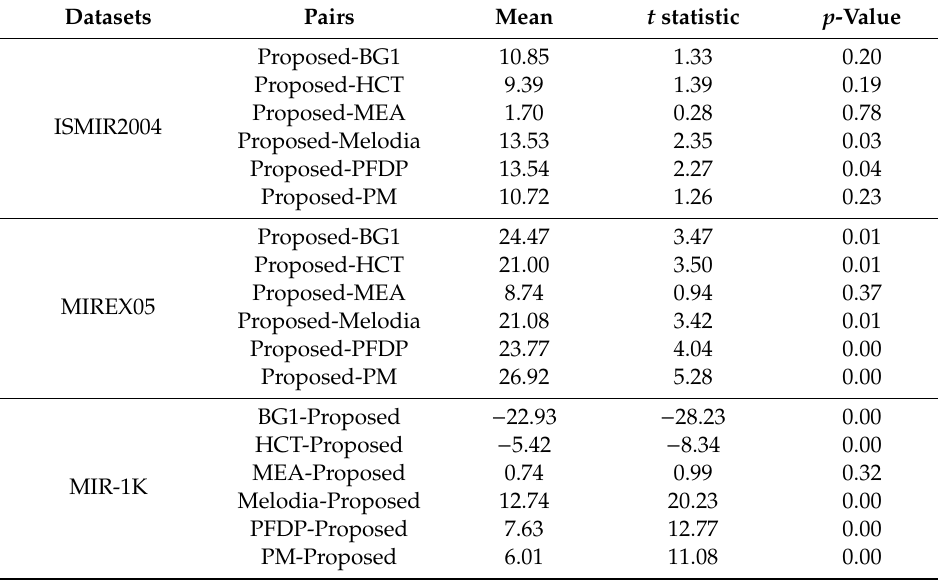
Table 4. Statistical significance analysis of a paired-sample t-test (raw pitch accuracy (RPA))between the proposed and reference